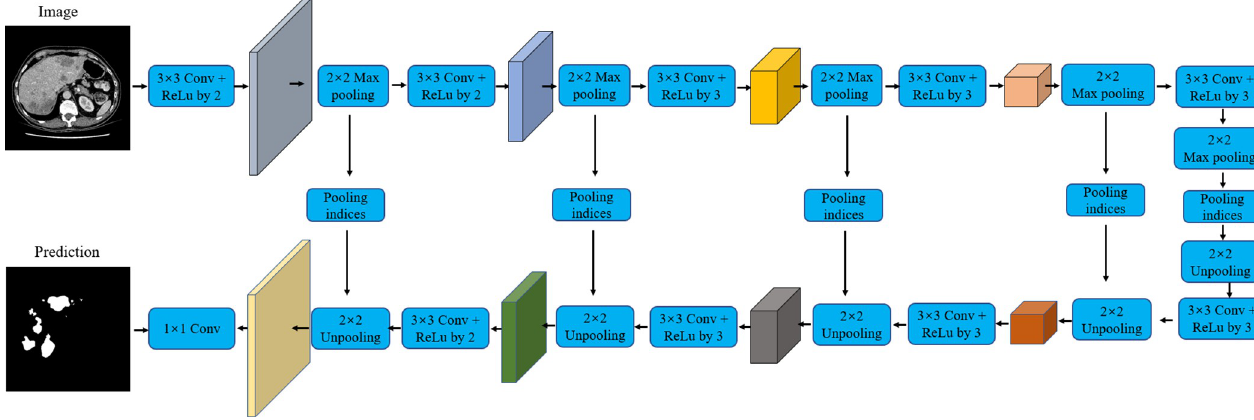
Fig 11. The detailed architecture of the